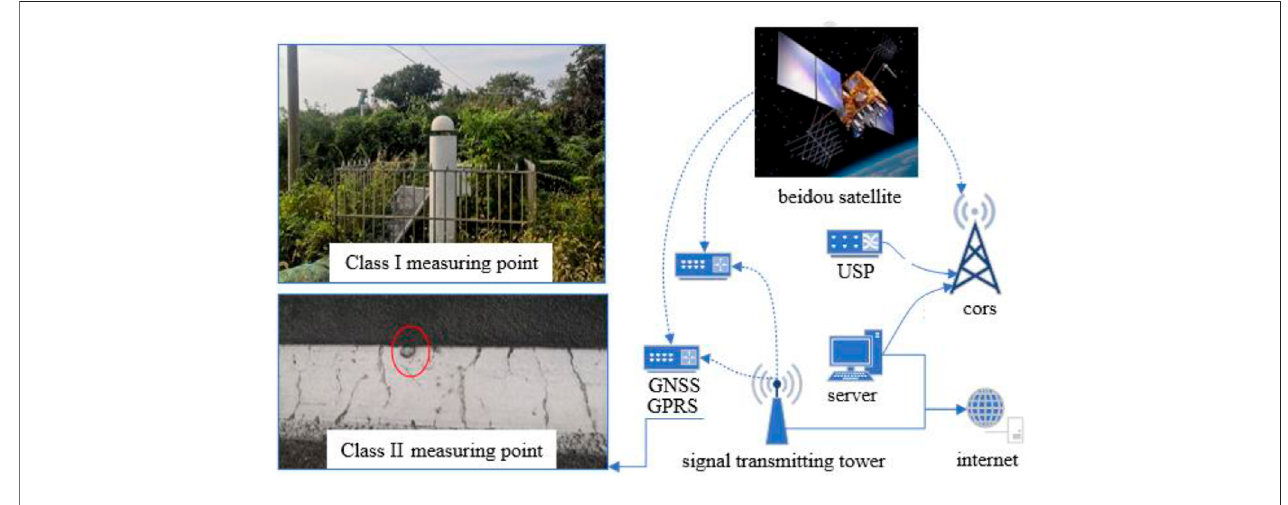
FIGURE 10 | Surface subsidence monitoring